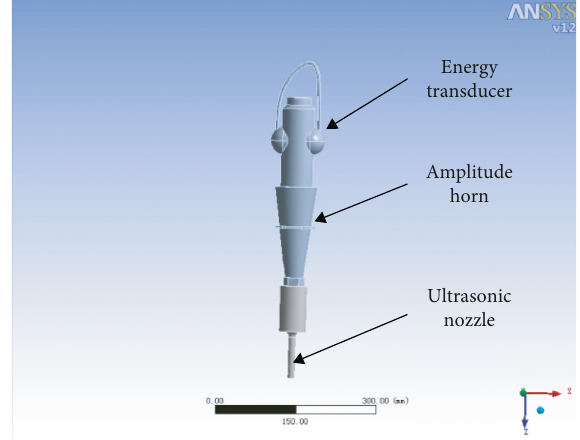
Figure 4: The 3D model.